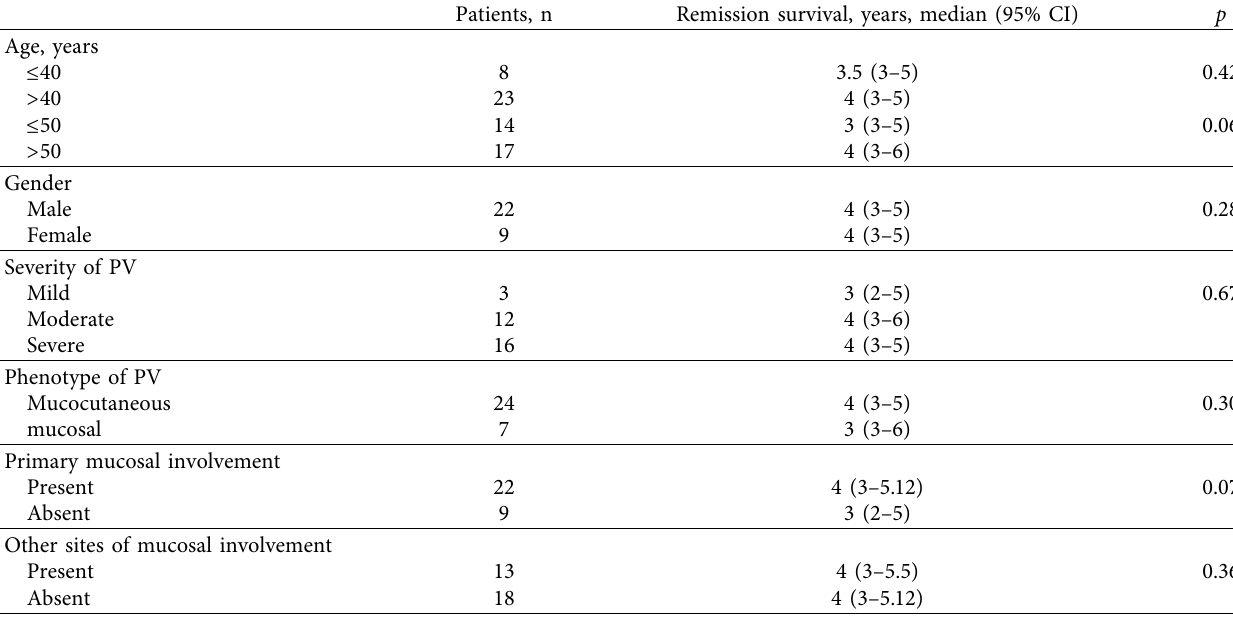
Table 2: Remission survival in patients with pemphigus vulgaris (PV).